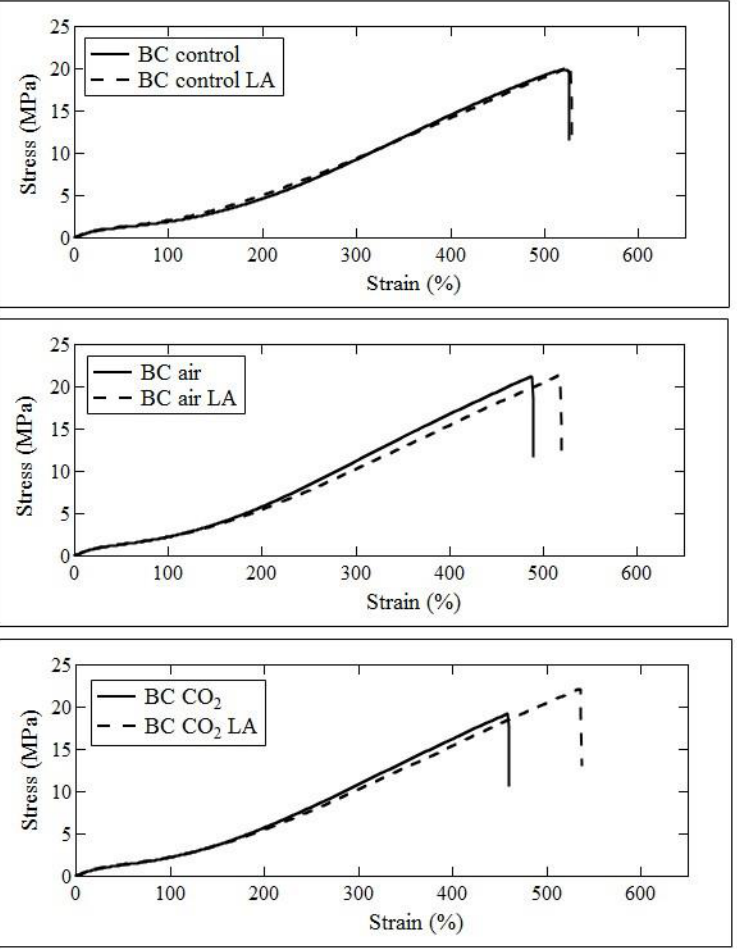
Figure 4. Stress – strain curves of LA-coated vs. uncoated rubber composite samples for the control ( top ), air-treated ( middle ), and CO 2 -treated ( bottom ) biochar samples. For each plot the single representative curve closest to the average tensile strength and elongation was chosen for clarity.